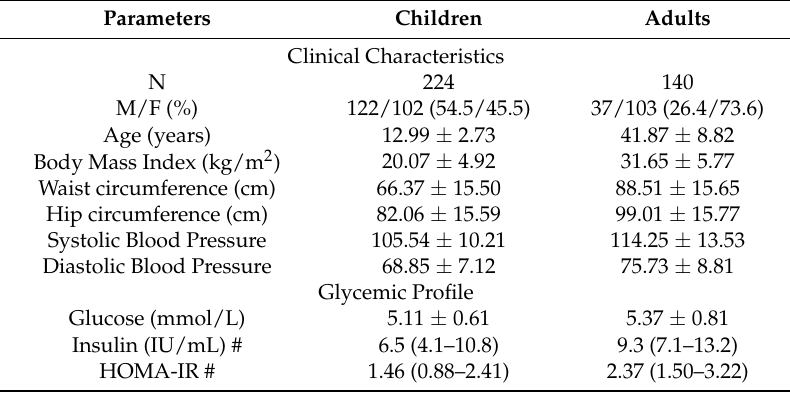
Table 1. Clinical characteristics, glycemic, lipid and metabolic profiles of